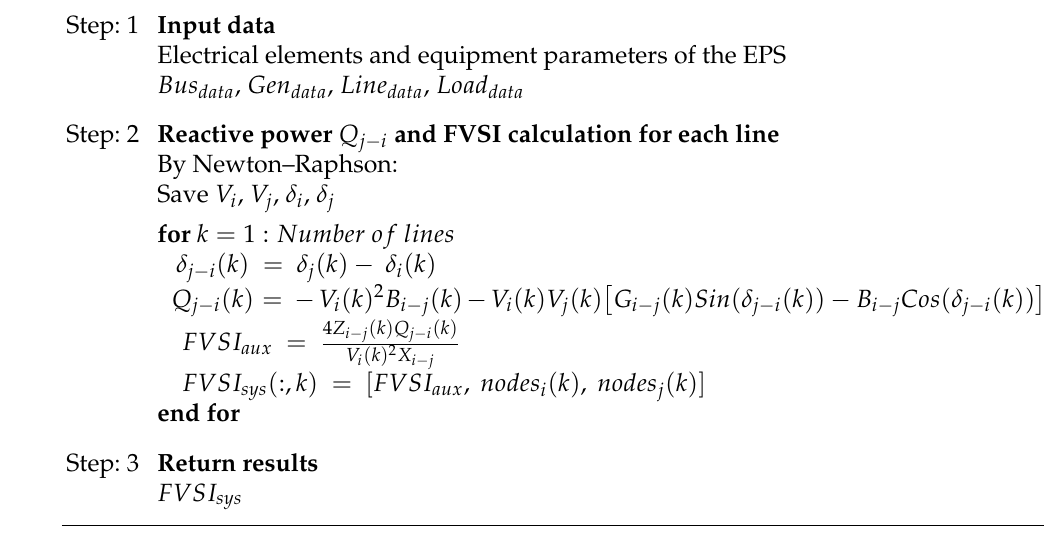
Algorithm 1 Fast voltage stability index